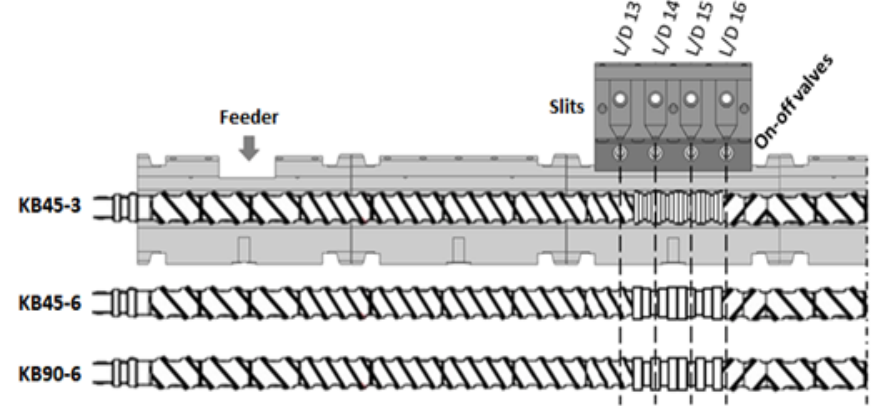
Figure 1. ( a ) Experimental set-up: modified barrel segment (1) with two axial rows of sampling devices (2a, 2b); multi-slit die (3); sliding optical detector with a C-shaped support (4); water-cooling system (5); light source (6a) and receptor (6b) for optical measurements and ( b ) Optical detector system: LED (6a) with a polarizer (7) and two LDRs (6b) with a polarizing filter (8).